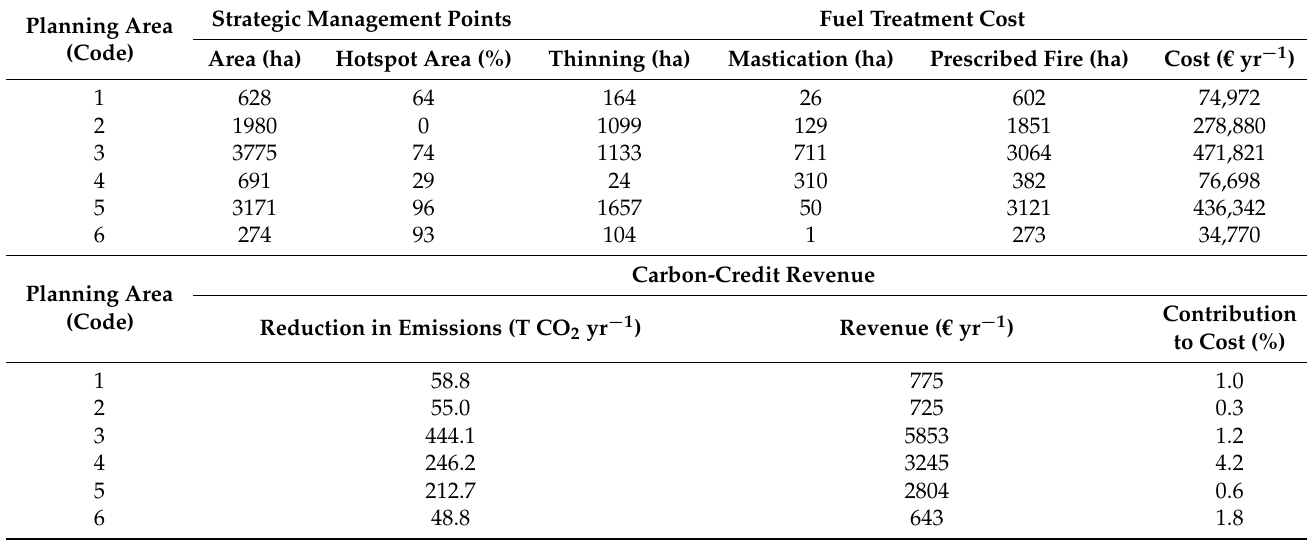
Table 4. Revenue from a potential carbon credit market in the different planning areas. We assumed a fuel treatment effective duration between 8 to 14 years. The wildfire managers implementing fuel reduction programs in the study area provided the treatment cost (Table 2). The SMP area over high emission hotspots (>0.01 CO 2 T ha − 1 yr − 1 ) was computed as a performance metric for the fuel reduction